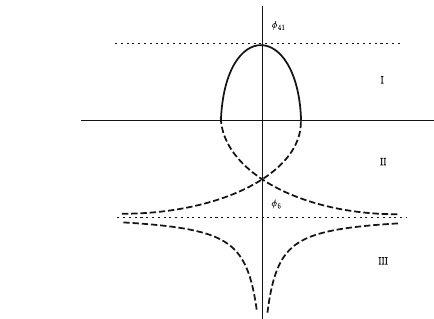
Figure 6: The graphs of the phase - portrait and the wave pro fi le when ( ) P ϕ has a double negative root ϕ and two conjugate complex roots.